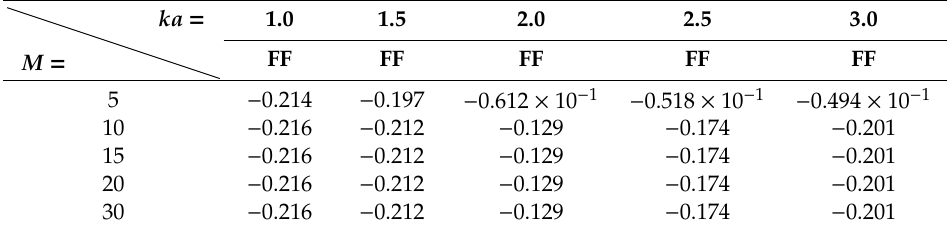
Table 4. Variation of the normalized mean drift wave force component involved in the far-field formulation, f − n , with respect to M ( d = 3 a , b = 2 a , and G 0 = 0.1).